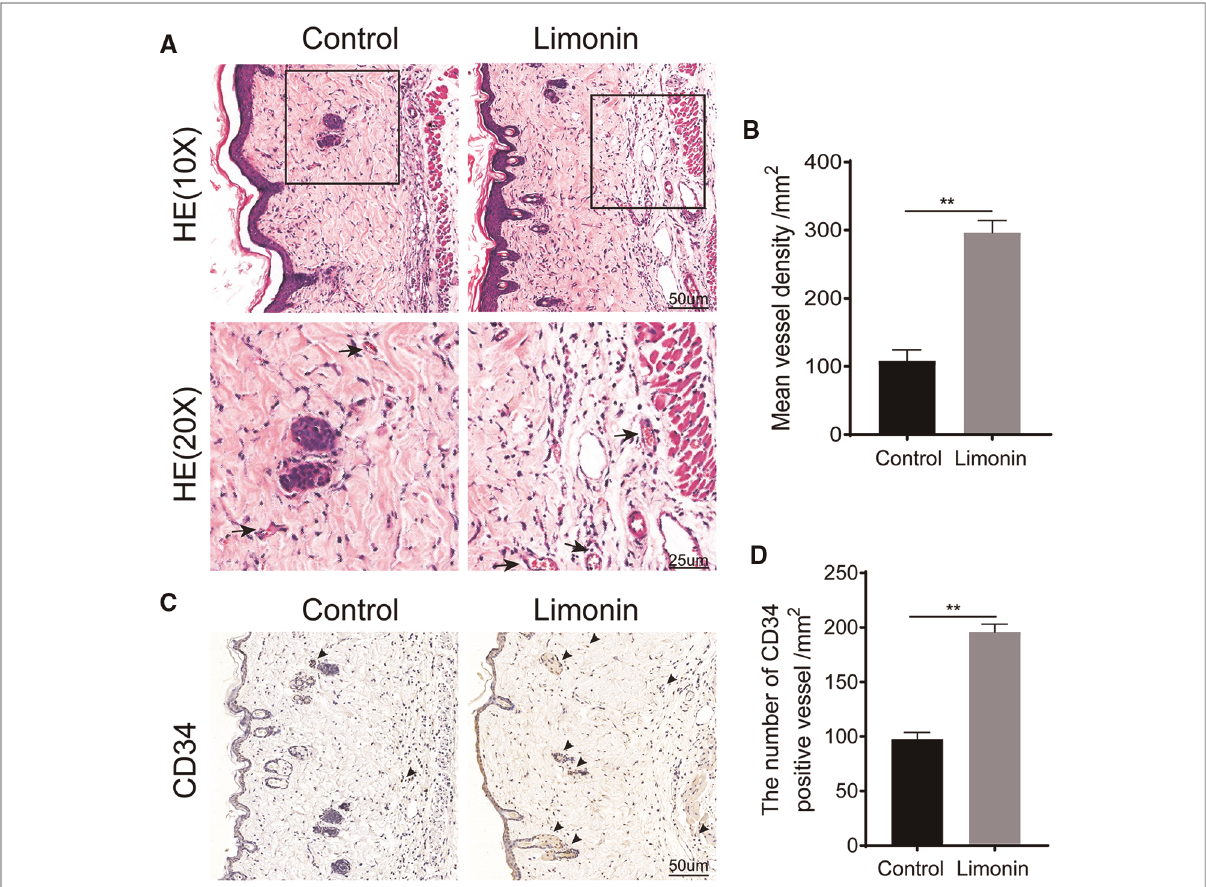
FIGURE 2 Limonin increased blood vessels in skin fl aps. ( A ) H&E staining showing microvessels (located with black arrows) in ischemic skin fl aps (area II) (original magni fi cation ×200 and ×400; scan bar, 50 and 25 μ m). ( B ) Mean vessel densities counted manually under H&E staining. ( C ) Immunohistochemistry staining of CD34-positive cells in fl ap area II. ( D ) CD34-positive vessel densities (/mm 2 ) quanti fi ed under immunohistochemistry staining. Data are mean±standard error of the mean, n =6 per group. ** P <0.01, vs. control